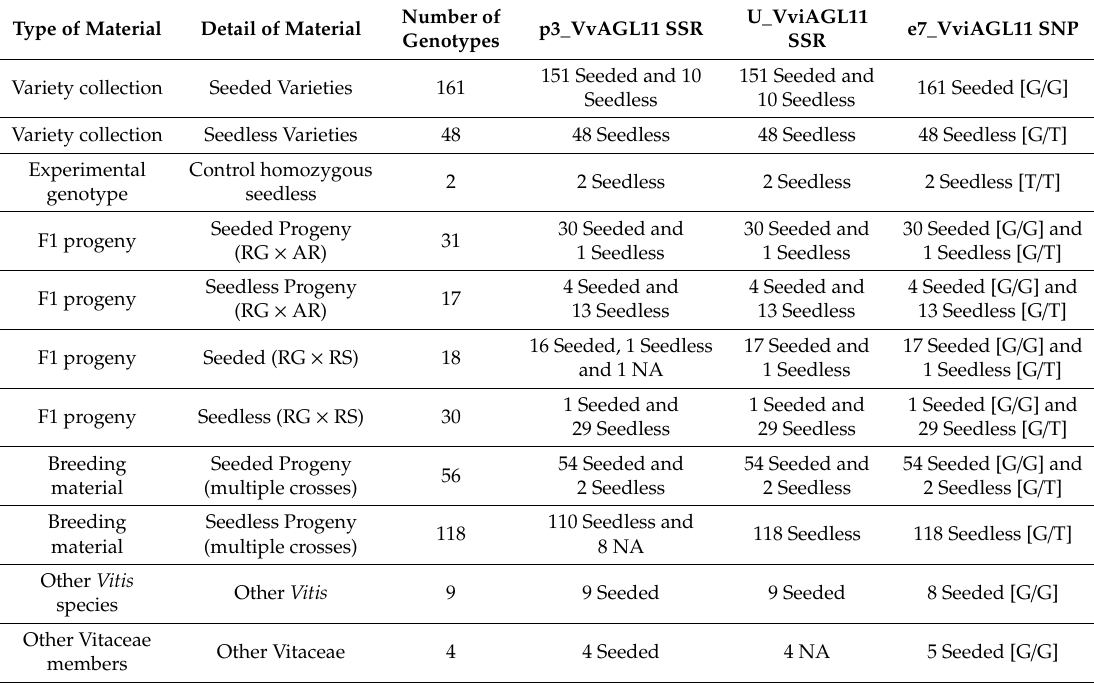
Table 3. Summary of analyzed material evaluated for validation